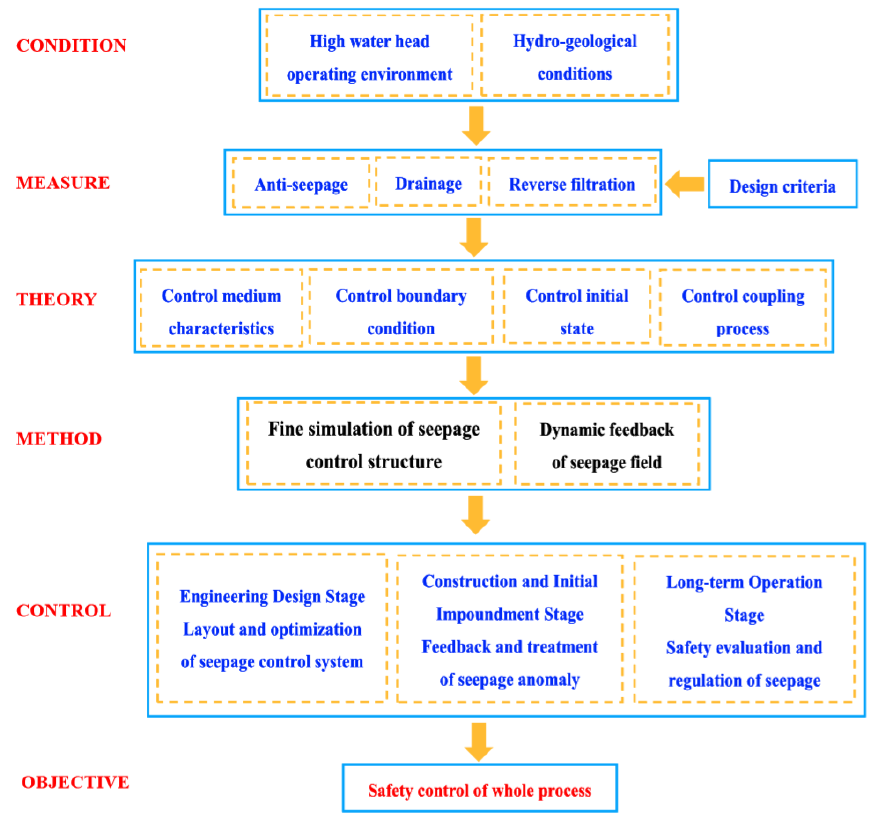
Figure 12. Optimization of the design method for seepage flow control of high-steep slope engineering